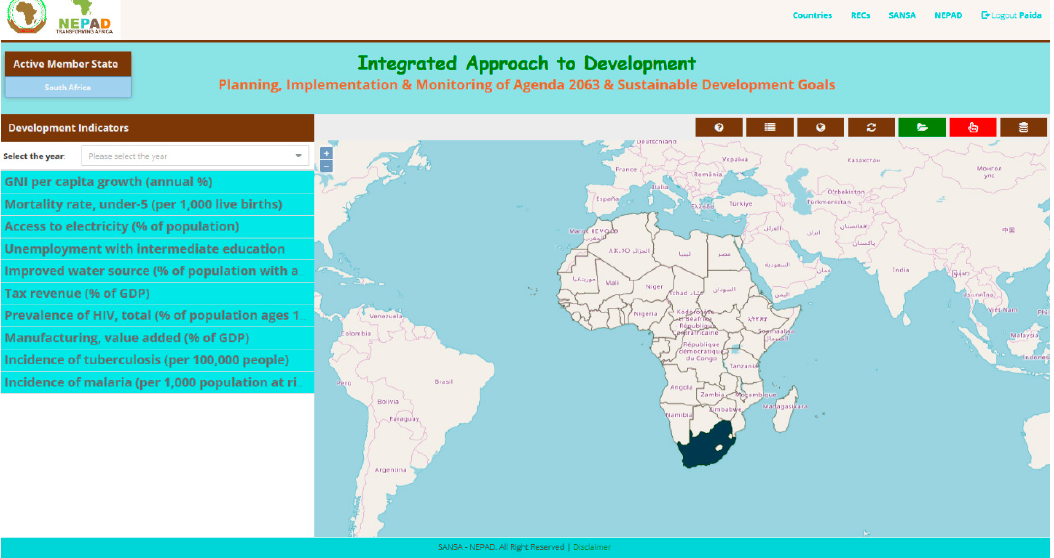
Figure 4. Front end interface for interacting with the geoportal.